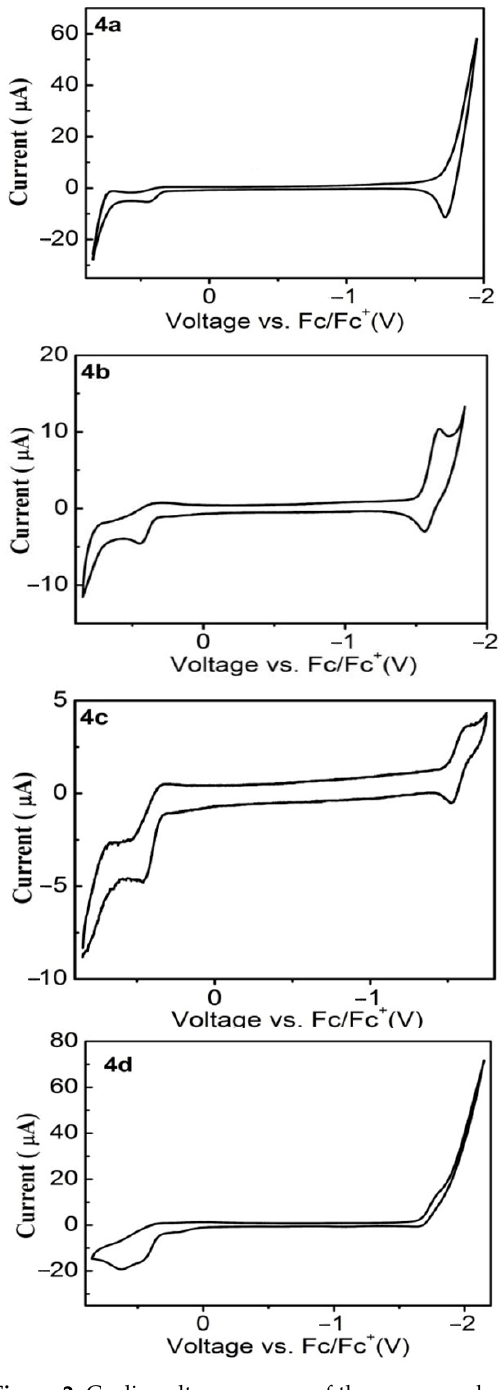
Figure 2. Cyclic voltammogram of the compounds. Table 2. Electrochemical properties of the compounds.